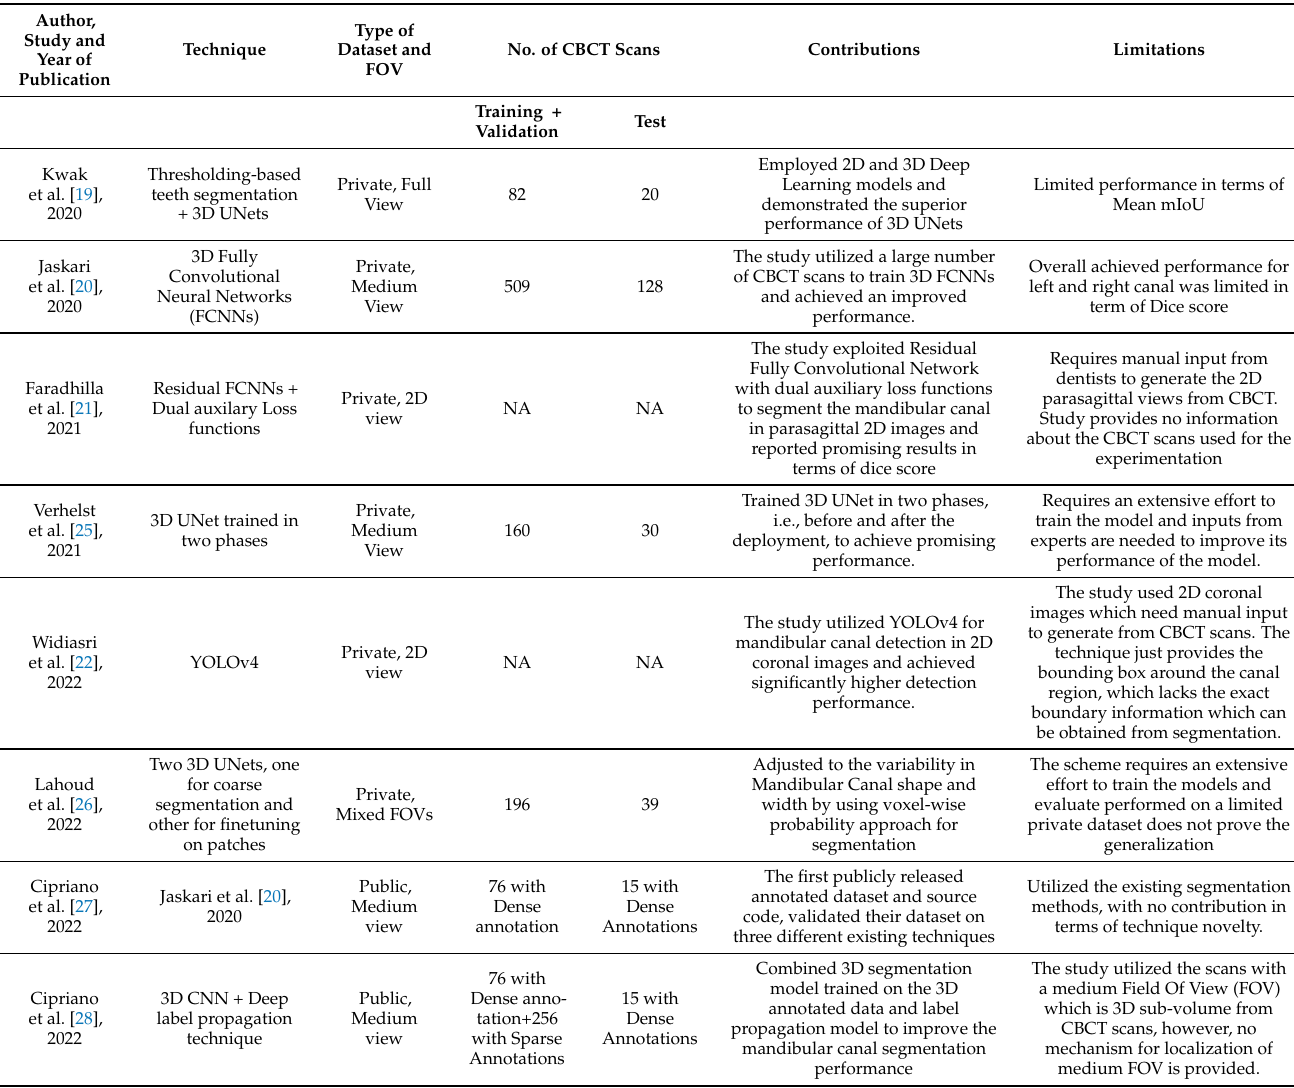
Table 1. Summary of recently published deep learning-based methods for mandibular canal segmen- tation in CBCT